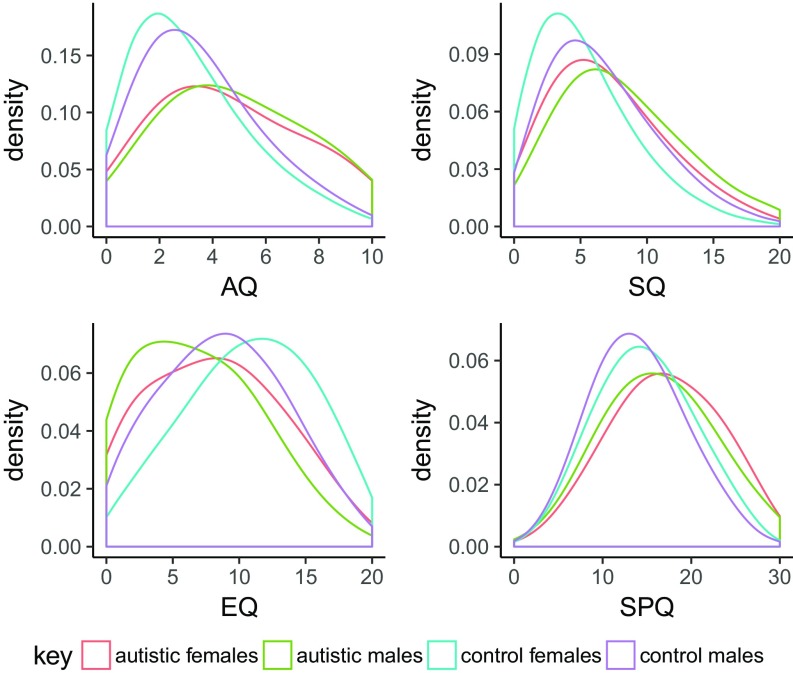
This figure provides the smoothed density plots for all four measures. Each separate graph represents a measure, with scores on the measure provided on the x axis. The density is provided on the y axis. Each colored line represents a category based on diagnosis and sex.